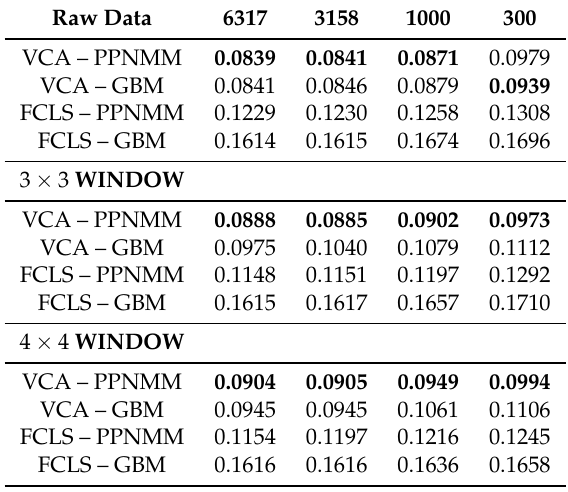
Table 5. Average abundance estimation error of the hybrid methods with different numbers of training samples (6317 to 300) and different window size vectors on the Samson data as compared with the abundance estimation error of the individual methods which are: PPNMM = 0.1455, GBM = 0.1588, VCA = 0.1254, and FCLS = 0.1577. The best results are shown in bold.